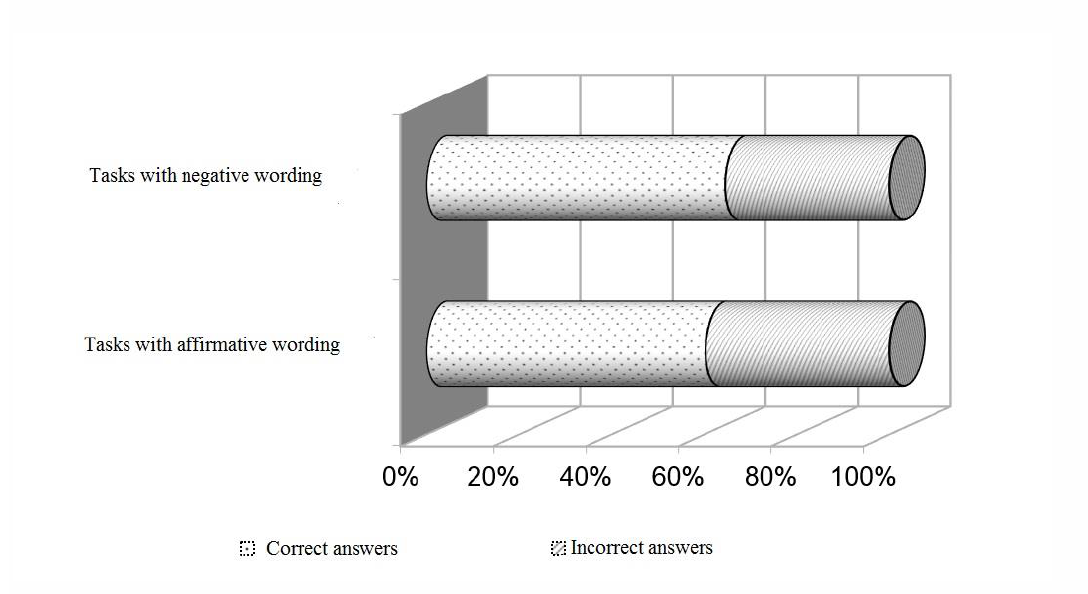
Figure 4. Results according to two types of problem